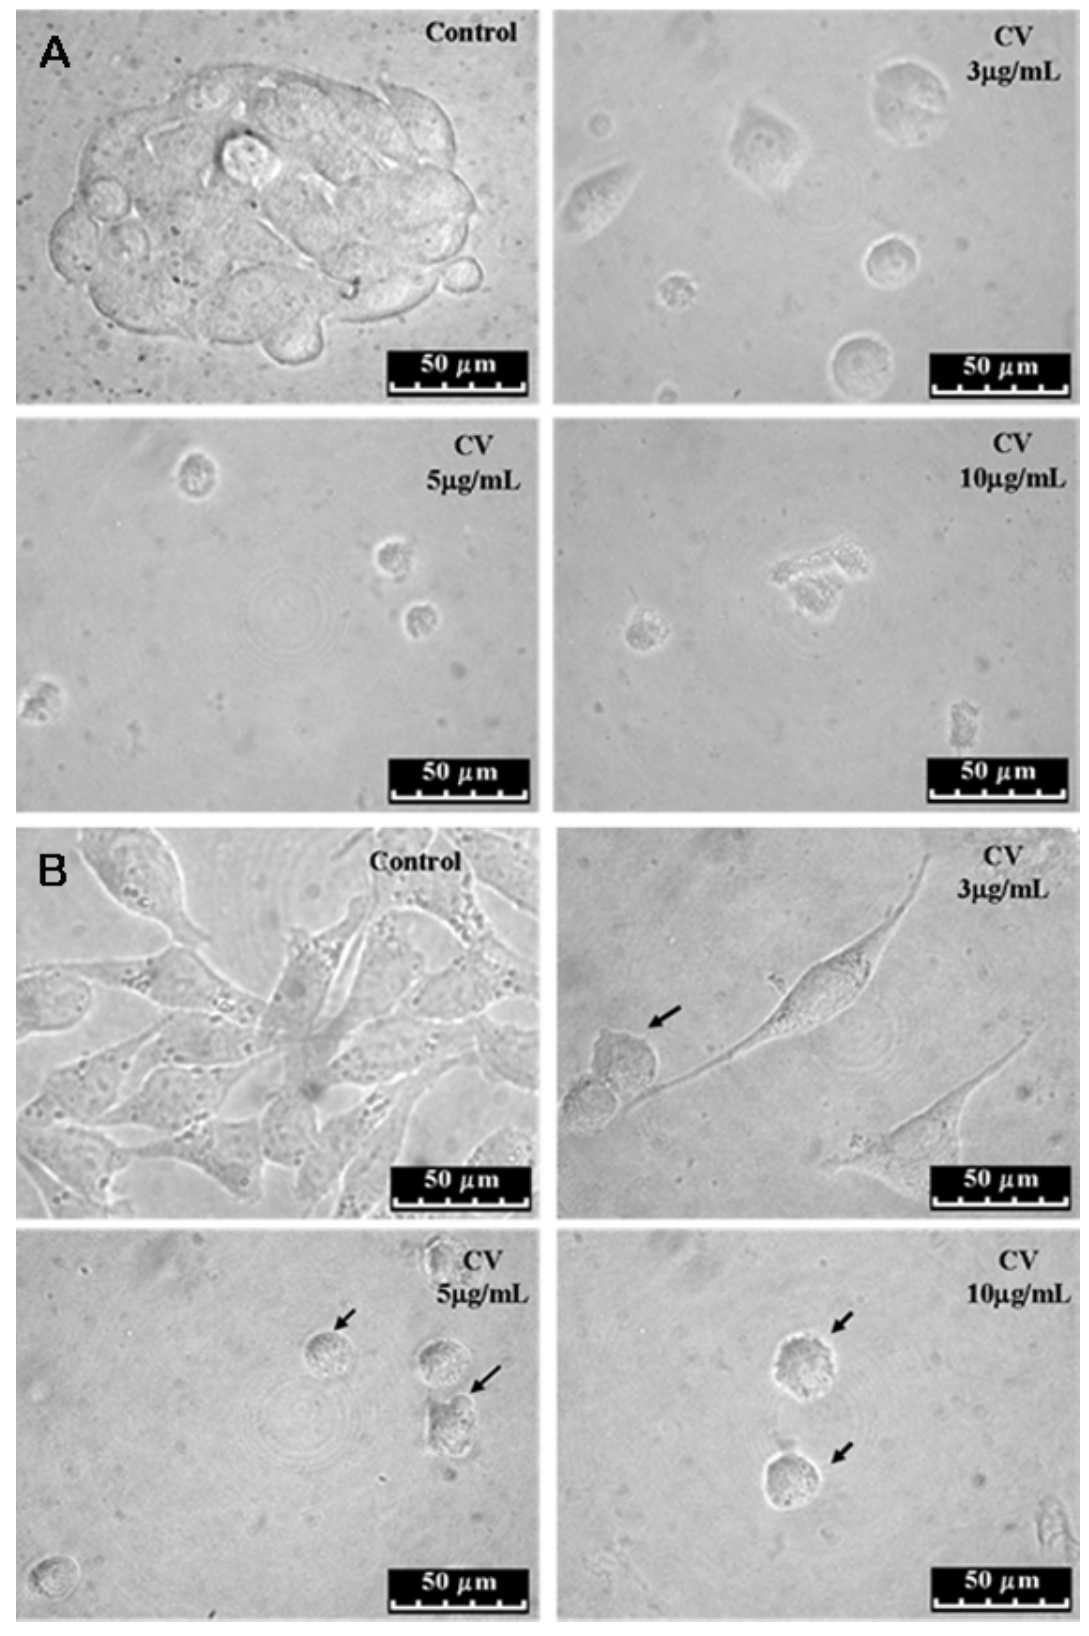
Figure 2. CV induces morphological changes in brain tumor cell lines. Photomicrographs from phase- contrast microscopy: ( A ) GH3 cells and ( B ) RT2 cells. Brain tumor cells were treated with different CV concentrations for 48 hours. Cell shrinkage and irregularity in cellular shape (indicated by arrows) were seen in the CV-treated